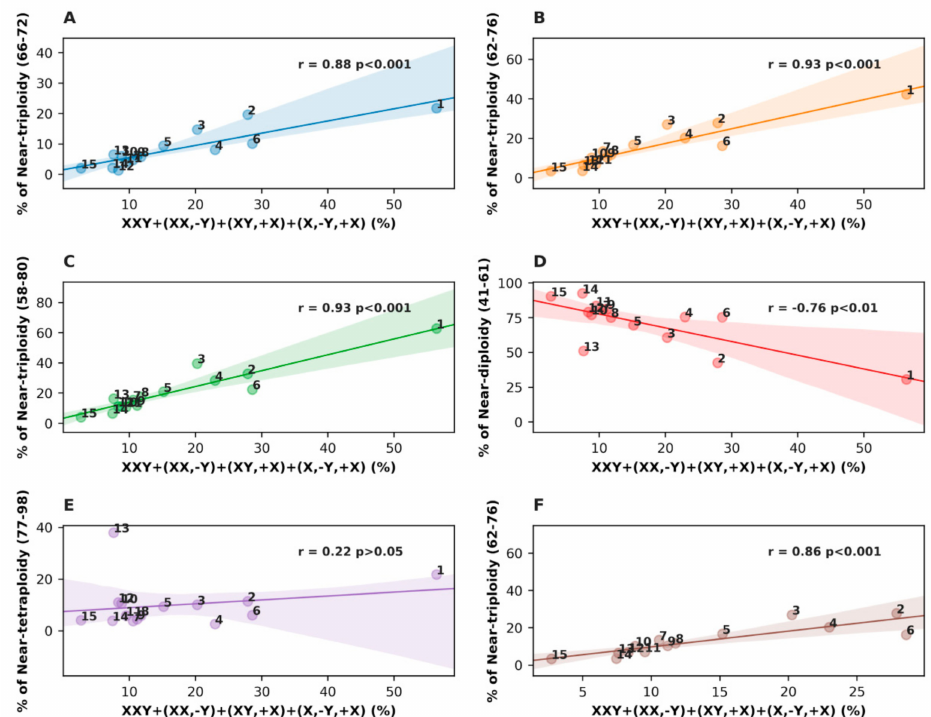
Figure 2. Results of the Pearson correlation analysis for all 15 patient karyotype cohorts of malignant tumors, evaluating the relationship between all karyotypes containing doubled X-chromosomes and ploidy in di ff erent chromosome ranges: ( A ) In relation to the narrow triploidy range (66–72 chromosomes); ( B ) in relation to the median triploidy range (62–76 chromosomes); ( C ) in relation to the wide (International System for Human Cytogenetic Nomenclature, ISCN) triploidy range (58–80 chromosomes); ( D ) in relation to the near-diploidy range (41–61 chromosomes); ( E ) in relation to near-tetraploidy range (77–98 chromosomes); and ( F ) only malignant somatic tumors are presented as related to the near-triploidy median range. The tumor cohort numbers are the same as in Table